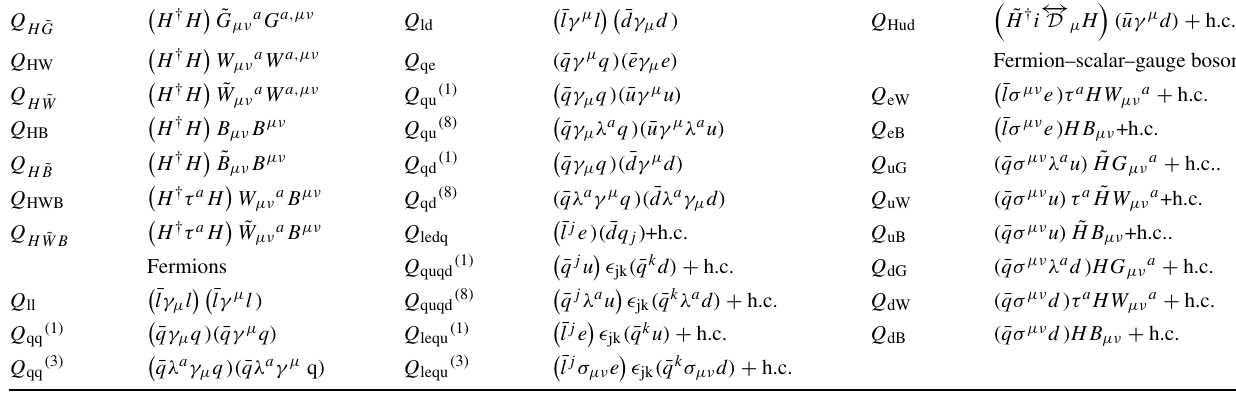
Fermion–scalar–gauge boson